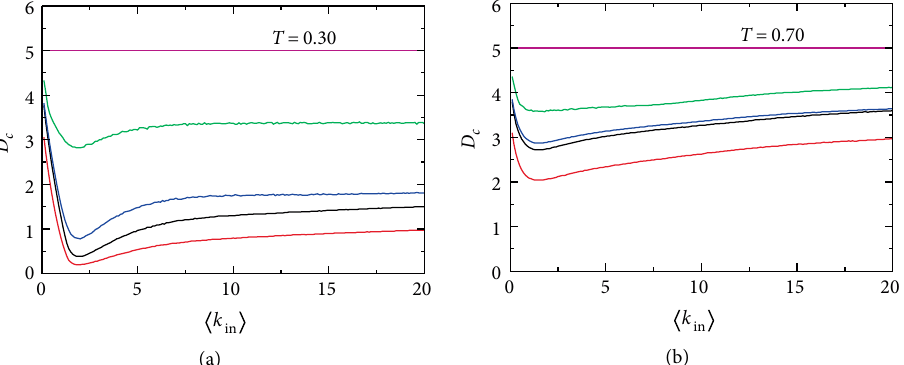
Figure 10: 𝐷 as the function of average degree of internal links ⟨𝑘 in ⟩ for 𝑇 = 0.30 (a) and 𝑇 = 0.70 (b) and for different weight distributions: 𝑐 uniform (black), exponential (red), truncated normal with 𝜎 = 0 (magenta), 𝜎 = 1 (green) and 𝜎 = 3 (blue). The internal degree distribution corresponds to an ER network. The initial shock is on the venture capital market.